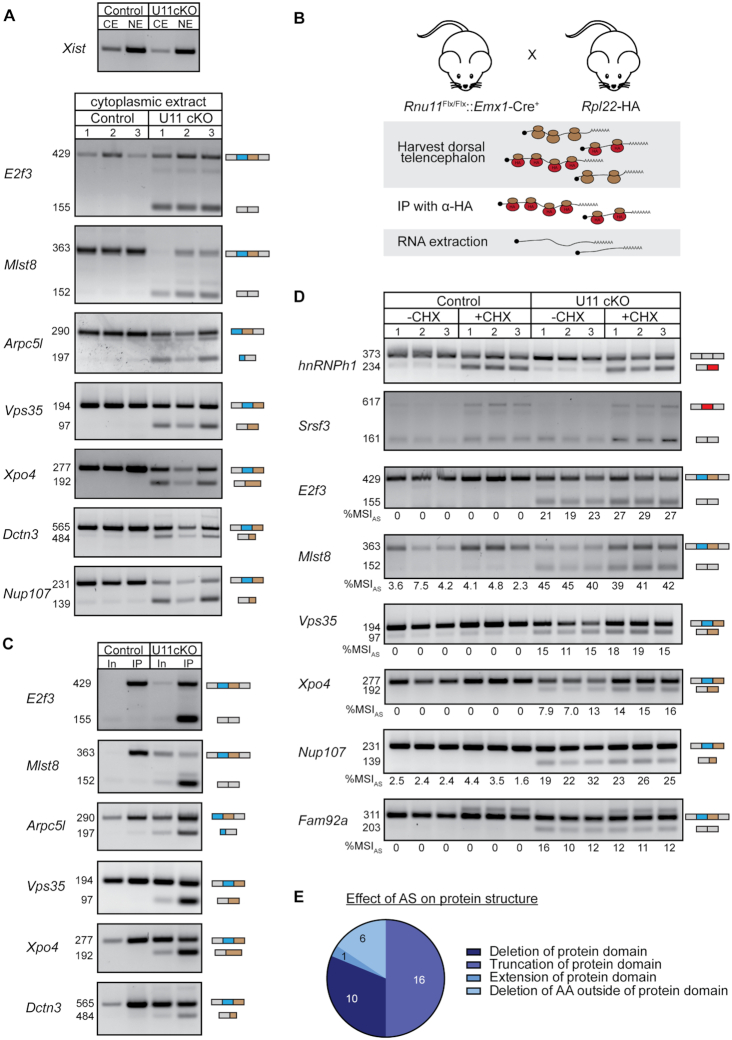
Alternatively spliced MIG transcripts are not subjected to NMD but bound to polysomes. (A) Agarose gel images showing the nuclear lncRNA Xist as a fractionation control; shown below are alternatively spliced RT-PCR products in the cytoplasmic fraction of the E12 dorsal telencephalon. (B) Schematic of experimental design to isolate RNA bound to polysomes in the U11 cKO Ribotag mouse. (C) Agarose gel images of alternatively spliced RT-PCR products in whole extract (In, input) and bound to polysomes (IP) of E14 control and U11 cKO dorsal telencephalons. (D) Agarose gel images of alternatively spliced RT-PCR products in E12 control and U11 cKO cultured telencephalons with and without NMD inhibitor cycloheximide. The %MSIAS was calculated using ImageJ. (E) Pie chart with the effect of AS on protein domains of affected MIGs. AA = amino acid; CE = cytoplasmic extract; NE = nuclear extract; CHX = cycloheximide. See also Supplementary Figure S7.